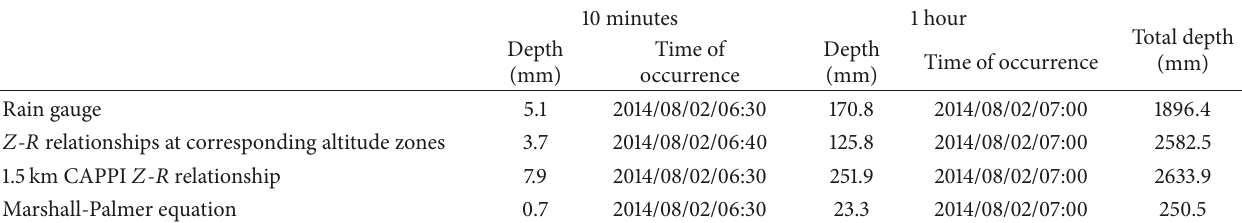
Table 2: Comparison of maximum areal-average rainfall depth recorded by rain gauge and radar for several rainfall